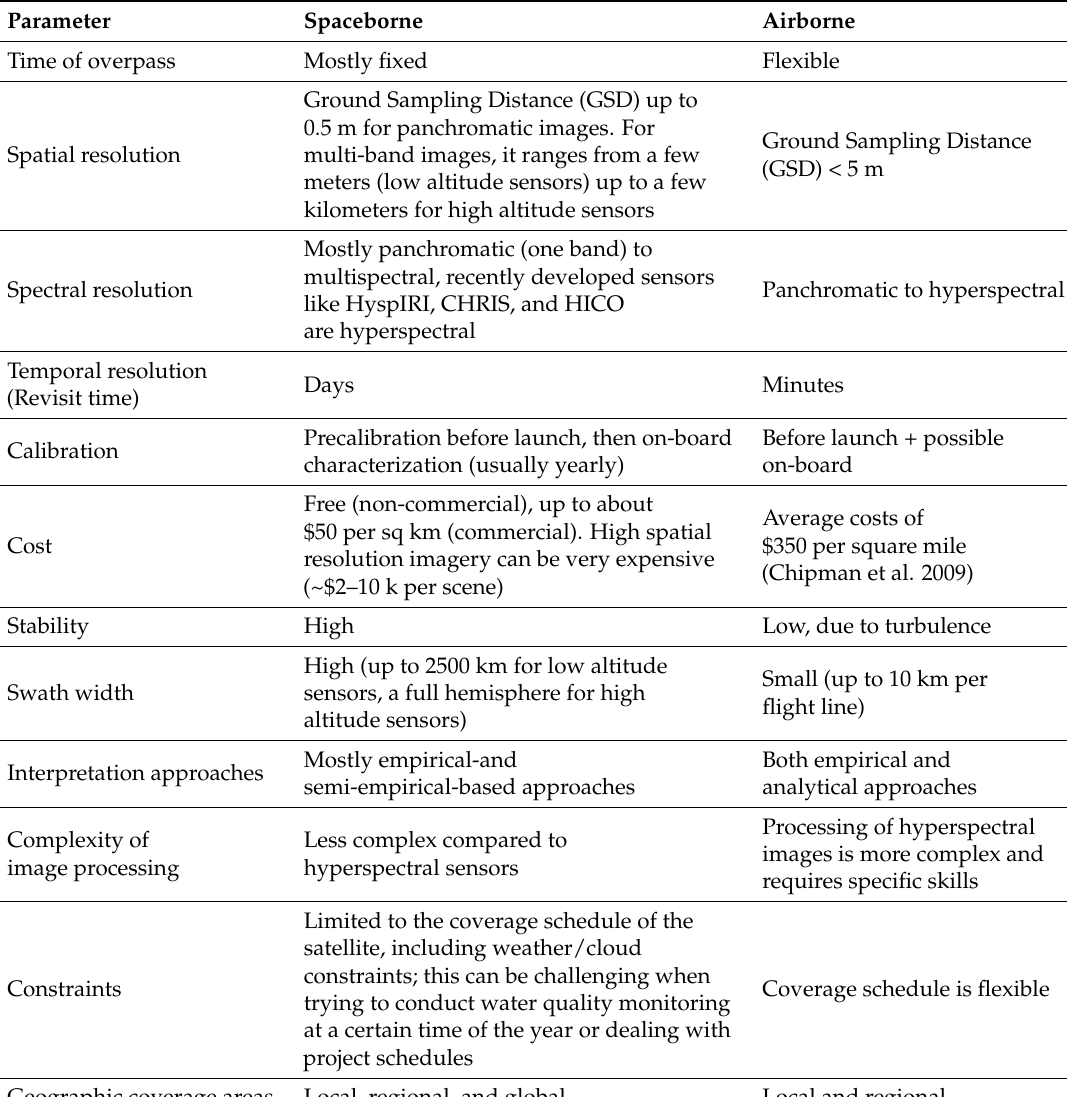
Table 13. Comparison between spaceborne and airborne